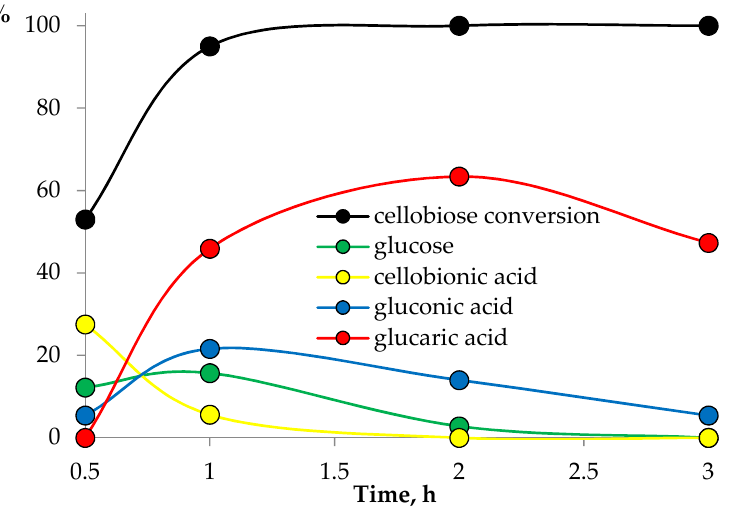
Figure 5. Dependence of the conversion of cellobiose and yields of the main products according to the reaction time (cellobiose, 0.2 g; 3% Pt/HPS MN270, 0.05 g; H 2 O, 20 mL; 145 ◦ C; O 2 , 5